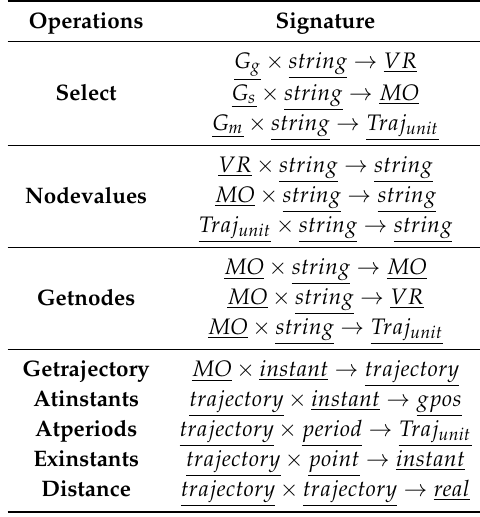
Table 1. Definition of